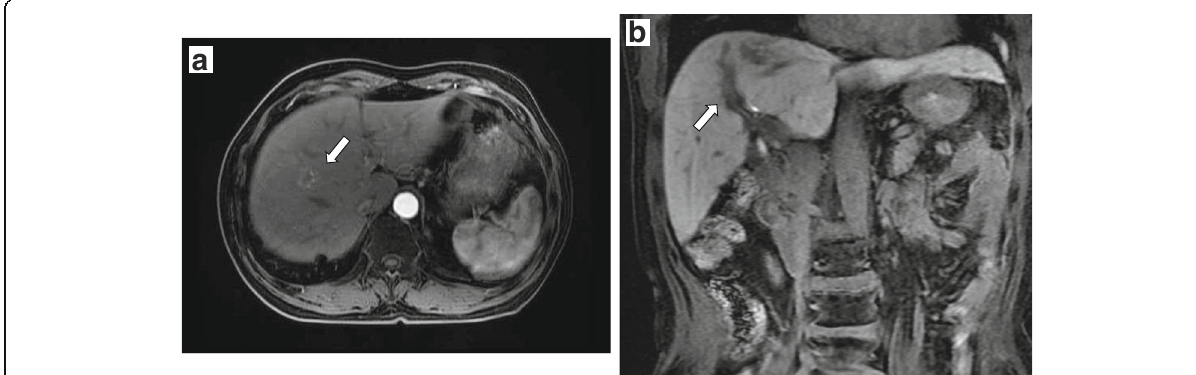
Fig. 3 Magnetic resonance imaging with gadolinium ethoxybenzyl diethylenetriaminepentaacetic acid. a Imaging detected a ring-like space- occupying lesion within P8 on dynamic study. b The tumor thrombosis progressed at the roots of the P5 and P8